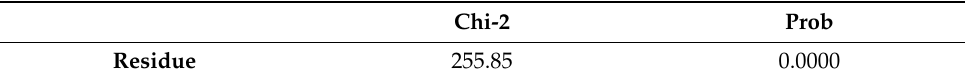
Table 8. Result of the Wald test.